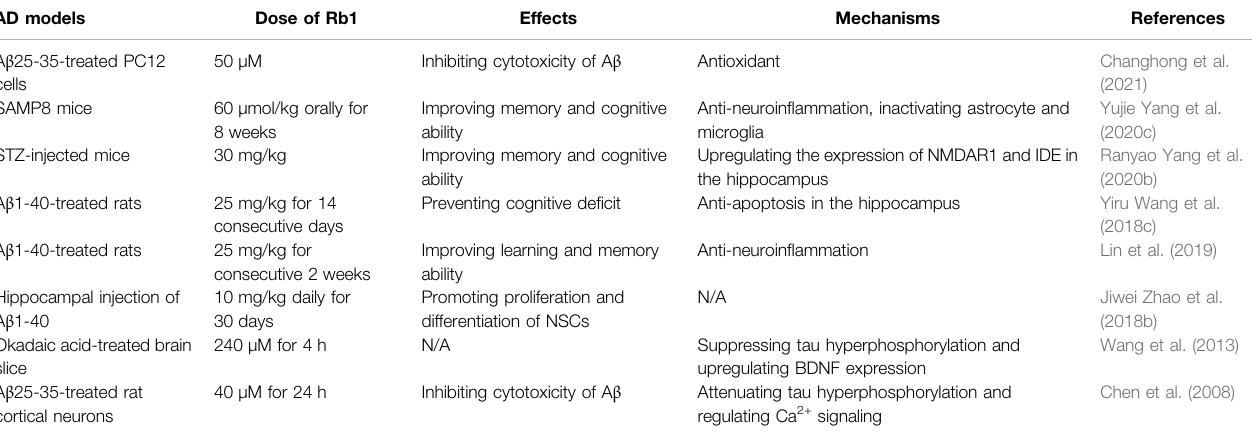
TABLE 1 | The neuroprotection of ginsenoside Rb1 in